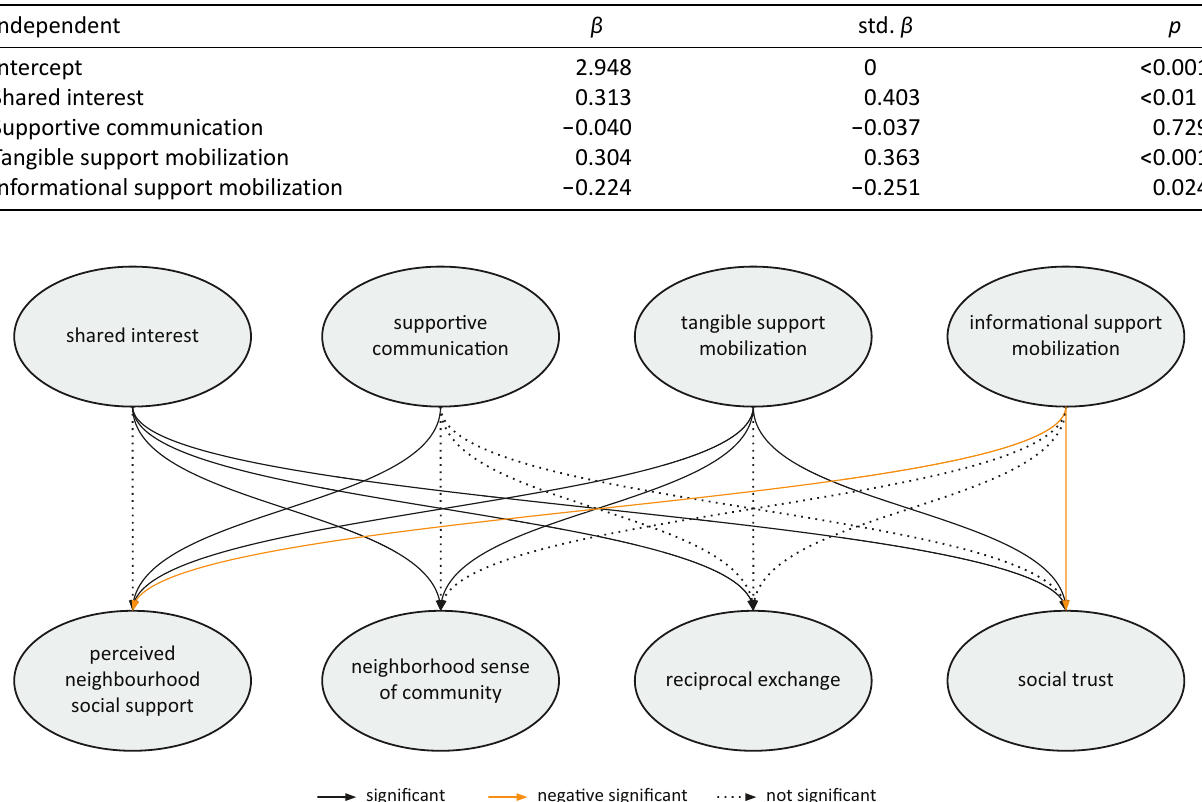
Table 7. Determinant table (regression on social trust).